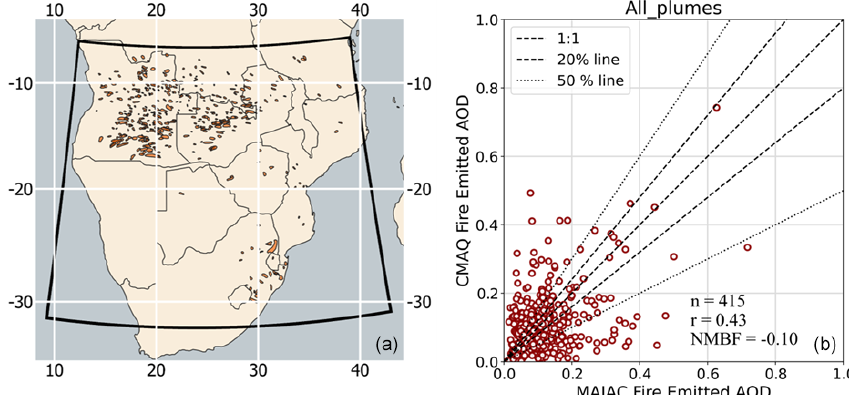
Figure D3. Location of smoke plumes identified in the MAIAC 1km AOD product between 15 June and 29 August 2019 and the bounding polygons used to define the area over these plumes (a) . Relationship between fire-emitted CMAQ AOD and observed fire-emitted MAIAC AOD in these plumes (b) . Pearson’s correlation and NMBF of the dataset are shown, along with dotted lines indicating the 1 : 1, 20% and 50% lines.